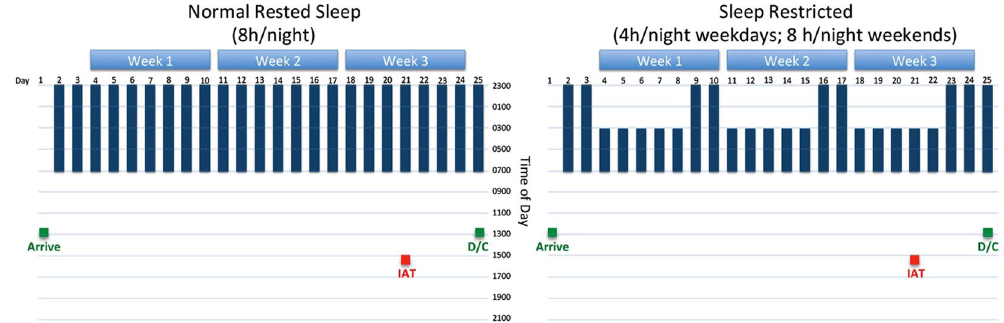
Figure 1. Diagram presenting the sleep and testing schedules for the sleep control and sleep restricted conditions. Sleep Restriction and Normal Rest conditions each comprised 25 days of confinement to a sleep laboratory. IAT = Implicit Association Test; D/C = Discharge from study